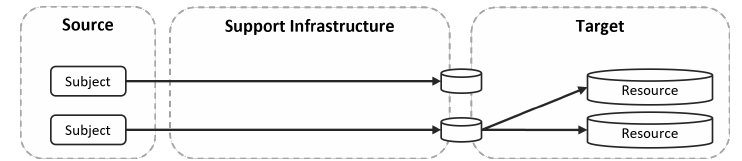
Figure 4. Target